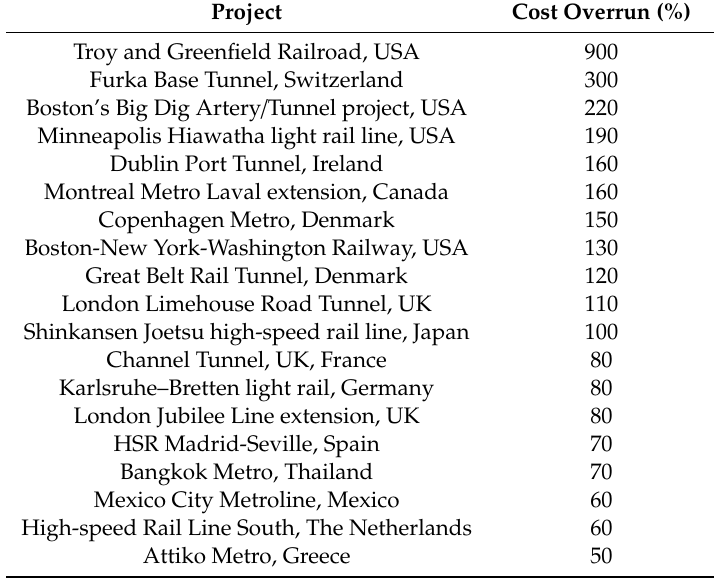
Table 1. History of cost overruns in tunnelling projects (according to [4] enriched with data from N.J. Brooks). Project Cost Overrun